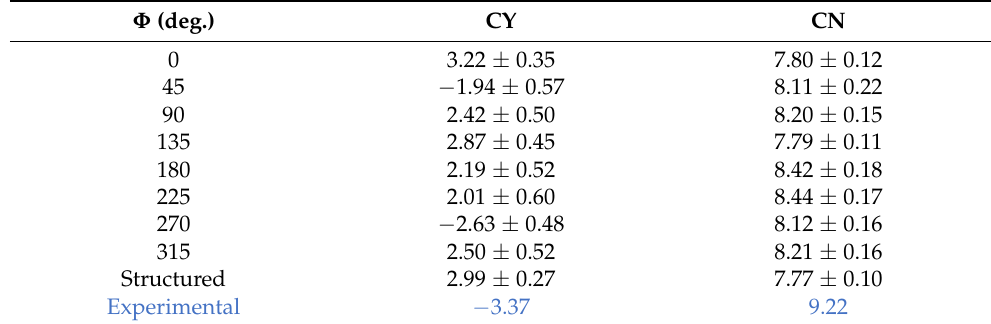
Table 1. Side and normal force coefficients versus orientation angle for the case at Ma = 0.2, Re = 2 × 10 6 , α = 45 deg. Unstructured and structured grids. Φ